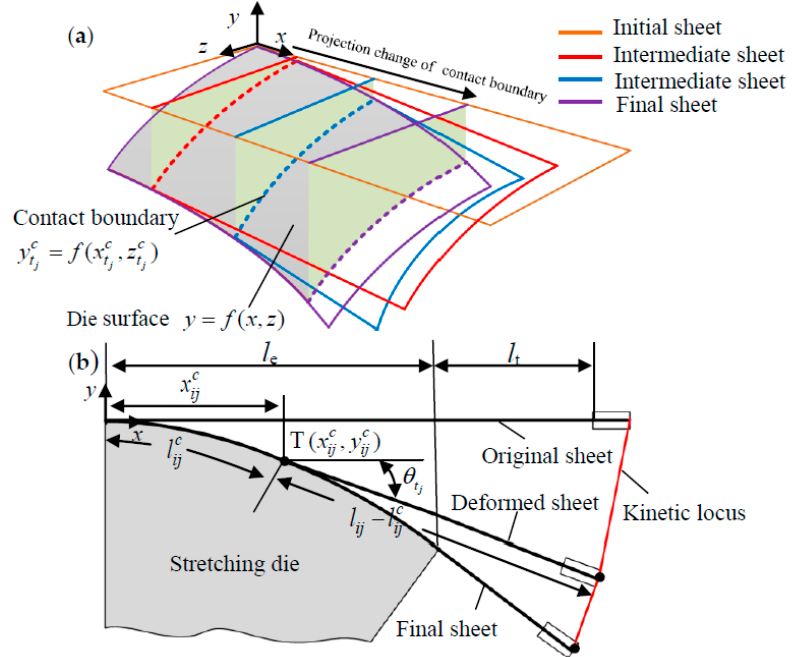
Figure 2. Schematic illustration of the design of UC-SF. ( a ) Uniform contact; ( b ) kinetic locus design.